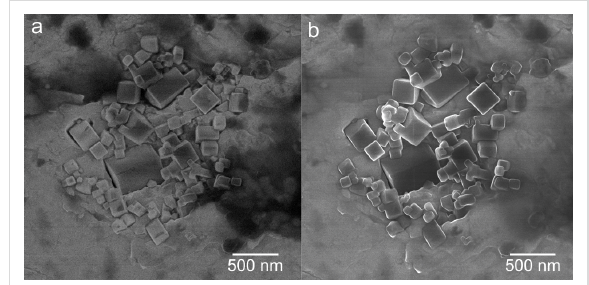
Figure 1: Effect of environmental water under high-vacuum conditions. Low-magnification HIM images of MgO cubes embedded in an indium foil after (a) 1 h and (b) 4 days in the HIM chamber (chamber pressure p < 3·10 − 7 mbar). Rounding of the MgO cube corners and edges is clearly visible in (b). (HIM SE images recorded at 30 kV acceleration voltage, (a) 0.3 pA beam current, 2.5·10 14 cm − 2 ion dose and (b) 25 kV acceleration voltage, beam current 0.1 pA, 3.0·10 14 cm − 2 ion dose).